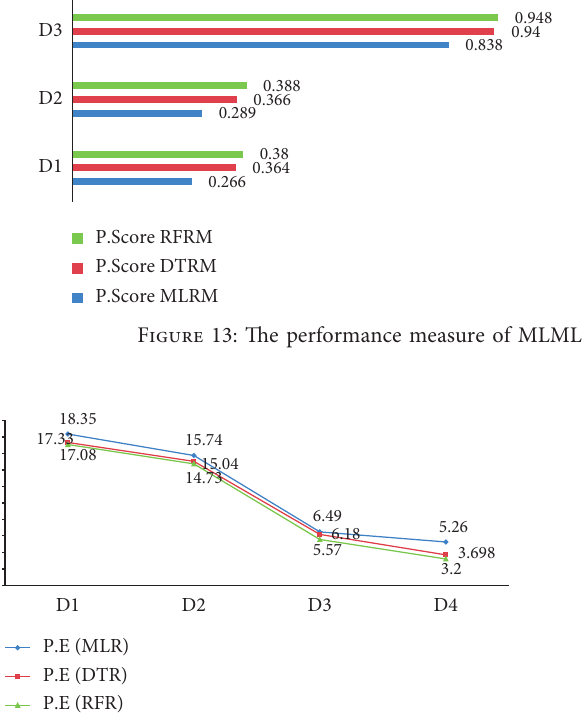
Figure 14: Integrating decomposition prediction error for MLR, DTR and